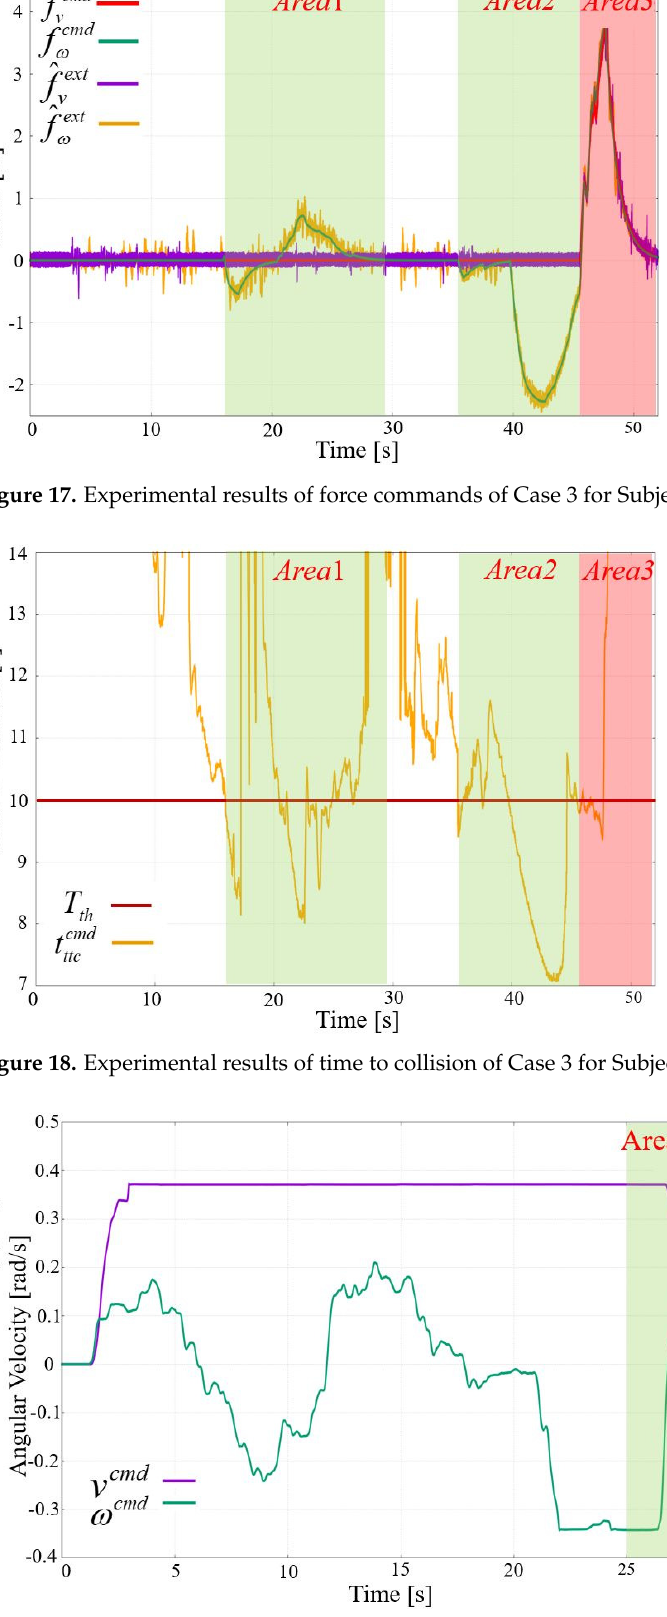
Figure 19. Experimental results of velocity of Case 4 for Subject